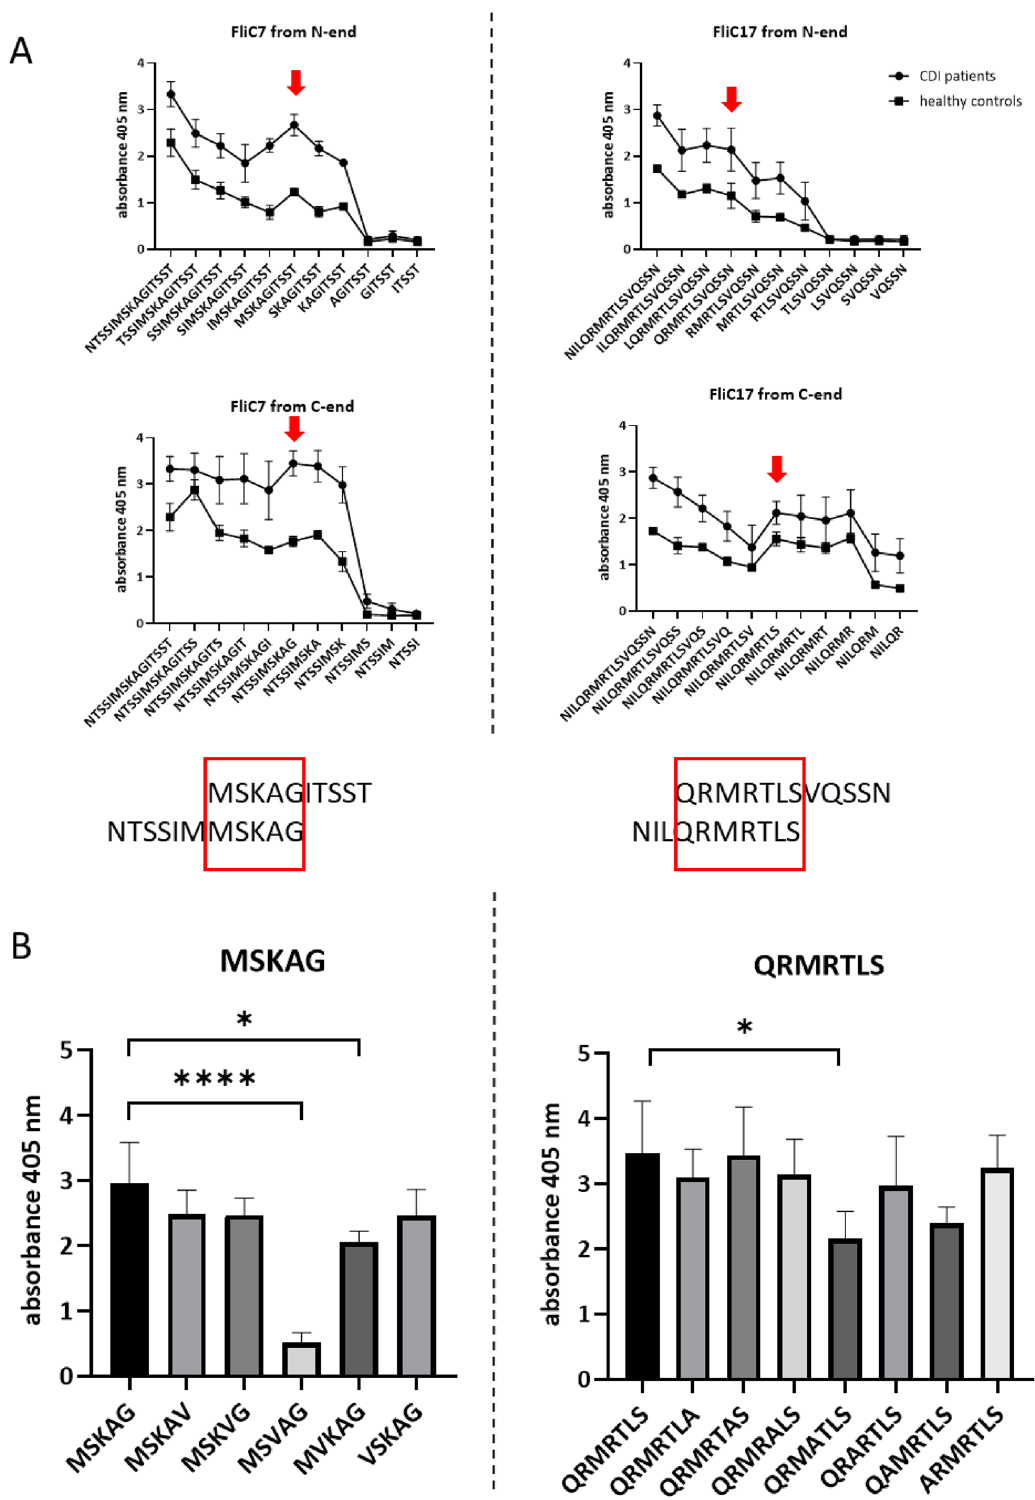
Figure 4. Mapping of C. difficile flagellin epitopes. ( A ) The analysis of the immunoreactivity of the library of truncated peptides of FliC7 and FliC17. Pin-bound ELISA was performed using pooled sera from C. difficile - infected patients and healthy volunteers (1:1000 dilution). Anti-human IgG conjugated with AP were used as secondary antibodies (1:10,000 dilution). Means with ± SD of three measurements are shown. ( B ) The “alanine walk” analysis of MSKAG and QRMRTLS epitopes. Pin-bound ELISA was performed using pooled C. difficile - infected patients’ sera (1:1000 dilution). Anti-human IgG conjugated with AP were used as secondary antibodies (1:10,000 dilution). Means with ± SD of three measurements are shown. Data analyzed with one-way ANOVA; * p < 0.0332; ** p < 0.0021; *** p < 0.0002; **** p <